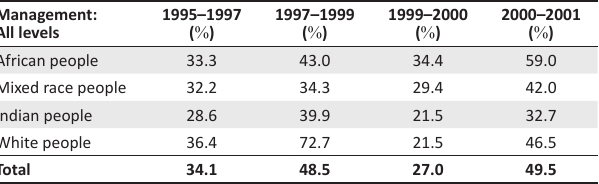
TABLE 3: Net change in female managers as a percentage of total change in management – All levels: 1995–2001. Management: All levels African people